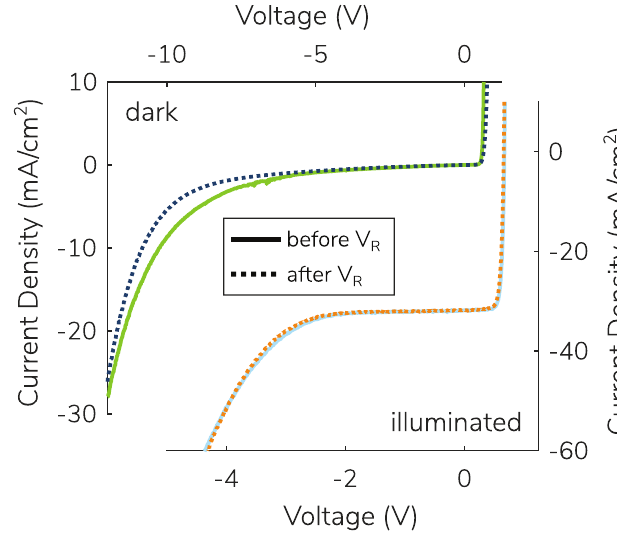
Fig. 8. In fl uence of a reverse-bias treatment (continuous (cid:3) 5 V for 10 min in the dark) on the dark (left and top axis) and illuminated (right and bottom axis) reverse IV